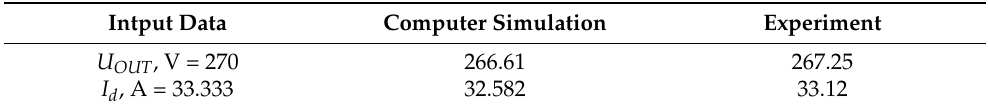
Table 2. Output data and obtained results from simulation and experiment for full-bridge transistor resonant inverter without reverse diodes.